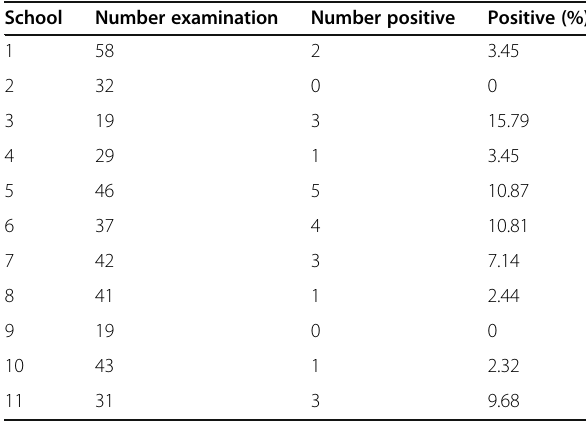
Table 1 Prevalence of Enterobius vermicularis infection among the study participants from the 11 kindergarten and primary